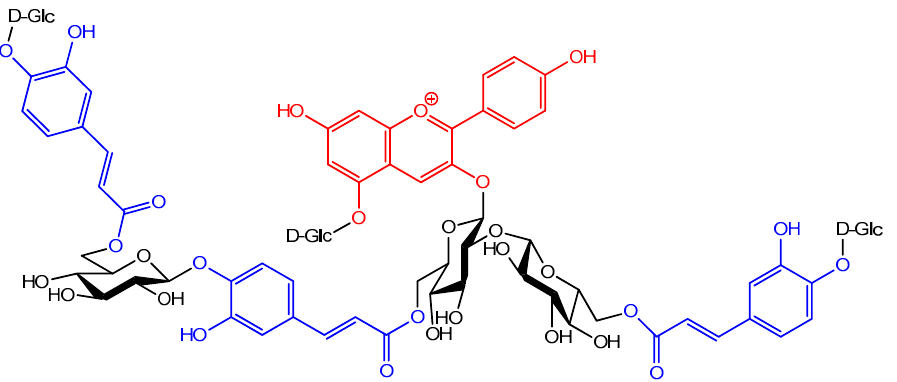
Figure 14. Triacylated ( B ) vs. non-acylated ( A ) Morning glory ( Pharbitis nil ) anthocyanins: equilibrium distribution of anthocyanin species in aqueous solution. Red solid line: flavylium ion, blue solid line: neutral base, dotted green line: total colorless forms. Parameters for plots are p K ’ h = 2.30, p K a1 = 4.21 ( A ); p K ’ h = 4.01, p K a1 = 4.32 ( B ). From [36,37].